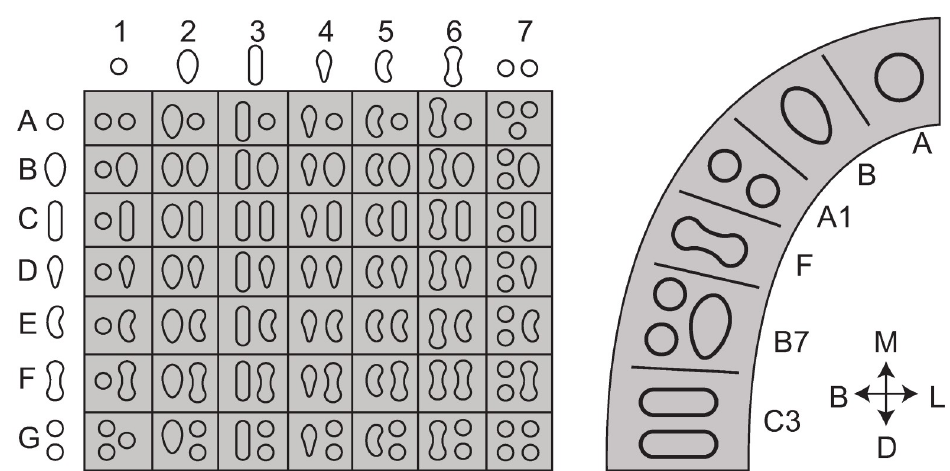
Fig 21. Variation in the tooth root complex. Left—Combinations of individual root types form multiple root complexes (e.g., C3 = one tooth with two plate shaped roots). Right—multiple root forms can appear in the tooth row. The left panel shows the range of possible combinations, while the right provides an